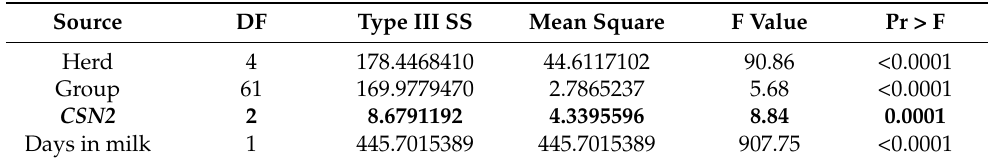
Table 11. Linear model (dependent variable: